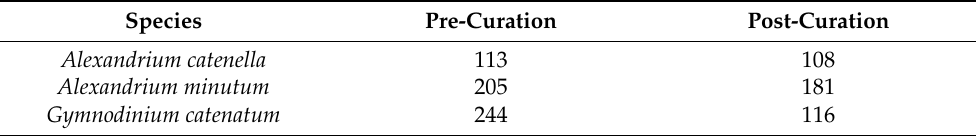
Table 1. Pre- and post-curation number of valid entries per species. Species Pre-Curation Post-Curation Alexandrium catenella 113 108 Alexandrium minutum 205 181 Gymnodinium catenatum 244